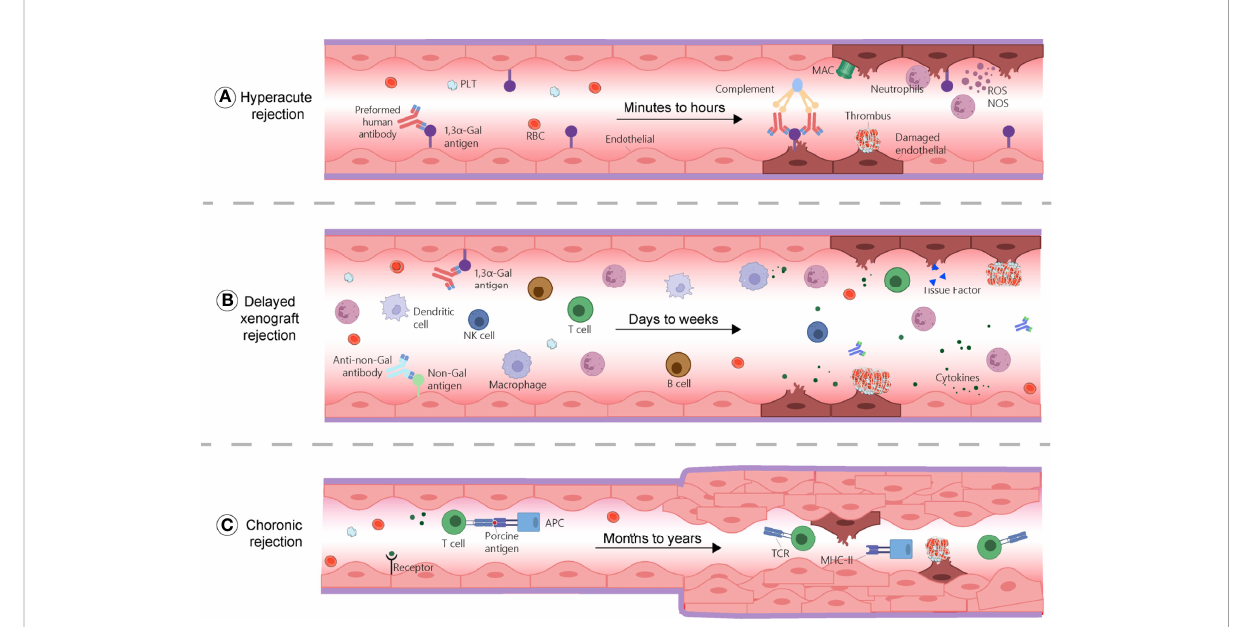
FIGURE 1 Mechanisms of rejections during xenotransplantation. (A) Hyperacute rejection occurs within minutes to hours and is caused by the binding of the host ’ s pre-existing antibodies to a -Gal antigens on the graft, which results in complement activation and membrane attacking complex (MAC) formation. This reaction causes endothelial cells lysis, fi brinoid occlusion, and vasculature destruction. Neutrophils, through the production of ROS and NOS also contribute to this process. (B) Delayed xenograft rejection (DXR) occurs within days to weeks and include acute humoral xenograft rejection (AHXR), cellular xenograft rejection, and coagulation dysregulation. AHXR is antibody-mediated and involve non-Gal antibodies and a -Gal antibodies reactivity against non-Gal epitopes and a -Gal of the graft. Various innate and adaptive immune cells, proin fl ammatory cytokines, and coagulation dysregulation contribute to rejection, resulting in massive deposition of immunoglobins, fi brin, endothelial cell lysis, and interstitial bleeding. (C) Chronic rejection occurs within months to years. Xenoantigens are surveyed by host APCs and presented to T cells, leading to their activation and triggering in fl ammatory cascades, characterized by thrombotic microangiopathy, proliferation of the graft vascular endothelial cells, vessel narrowing, and interstitial fi brosis. APC, antigen presenting cell; MAC, membrane attacking complex; MHC-II, major histocompatibility complex class II; NK cell, natural killer cell; NOS, nitric oxide species; PLT, platelet; RBC, red blood cells; ROS, reactive oxygen species; TCR, T cell